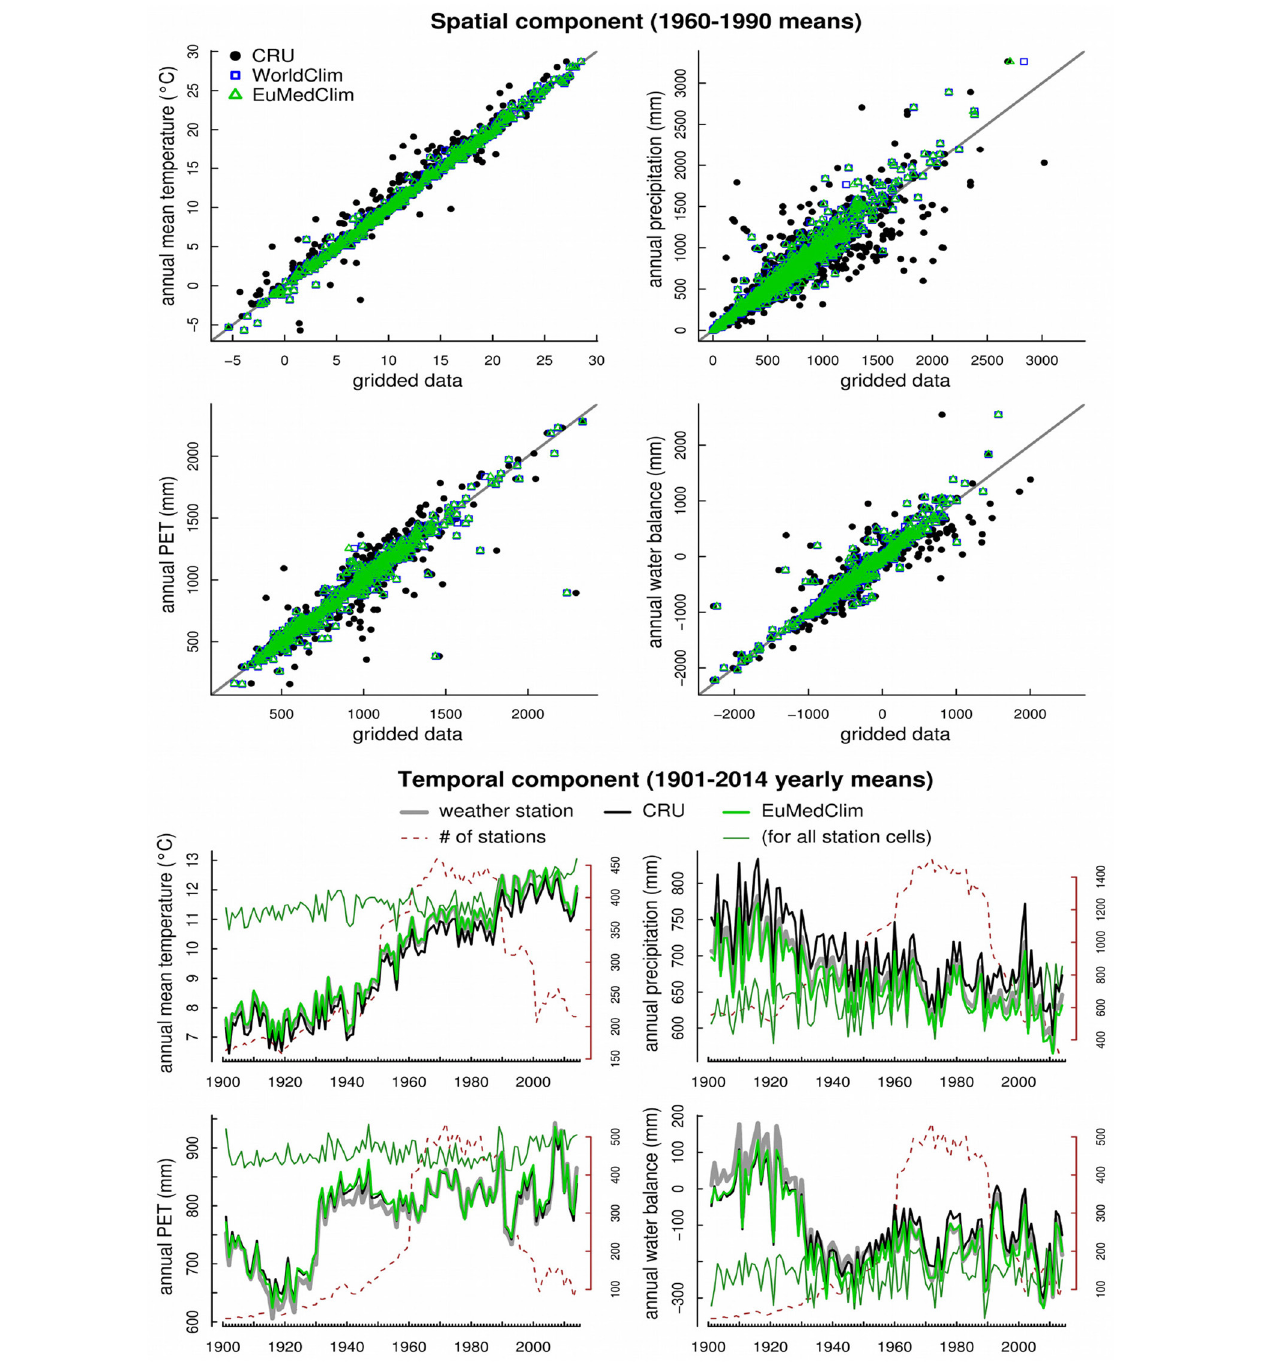
FIGURE 1 | Evaluation of the spatial and temporal components of EuMedClim and original gridded datasets against weather station data across Europe and Mediterranean Basin. For the spatial component, the black line is the 1:1 line. For the temporal component, the number of station and corresponding grid cell (#) used to compute yearly mean values changes over time as illustrated by the brown dashed line; the dark green line indicates the mean temporal trend computed from EuMedClim across the cells corresponding to all stations (i.e., independent to station data availability over time and space). Coefficients of determination, errors and the number of station (and corresponding grid cell) used in evaluation for the spatial component, and Kendall’s coefficients of correlation and errors for the temporal component are indicated in Supplementary Table 1. Evaluation at individual stations is presented in Supplementary Figure 1.